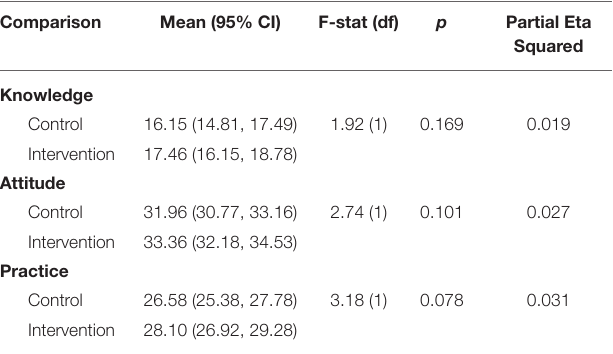
TABLE 3 | Comparison of KAP scores of RTI prevention among Hajj/Umrah pilgrims between groups (Group effect regardless of